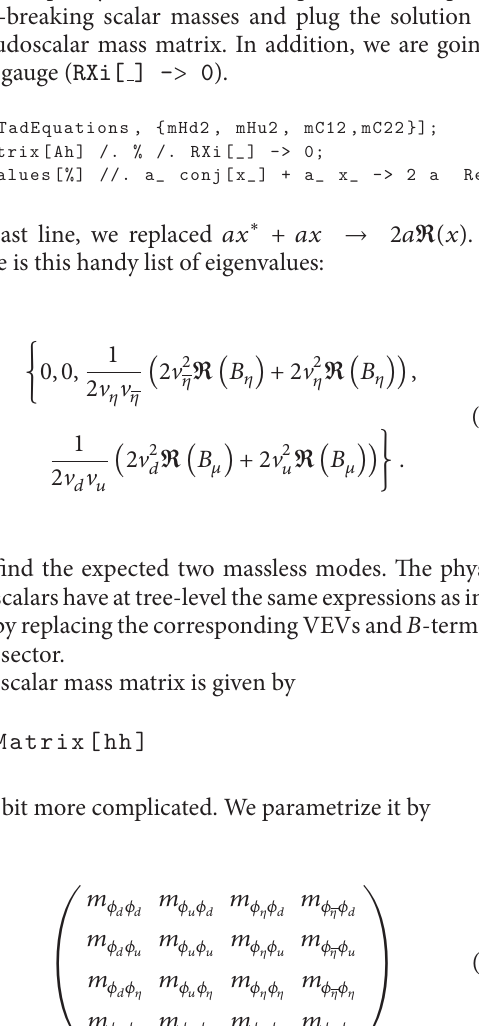
𝑀 𝑍 󸀠 = 2.5 TeV and